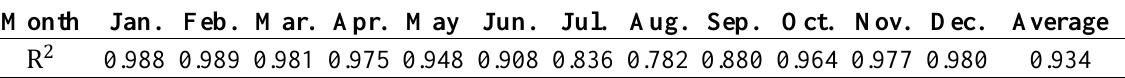
Table 2. R 2 in the OLS regression models calibrated for each month during 1979–2011. Month